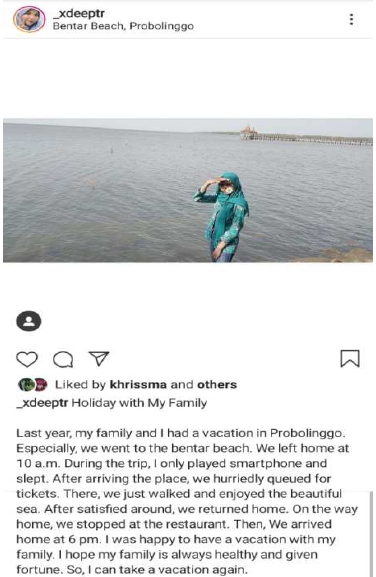
Figure 4. One of the students’ recount texts in Instagram